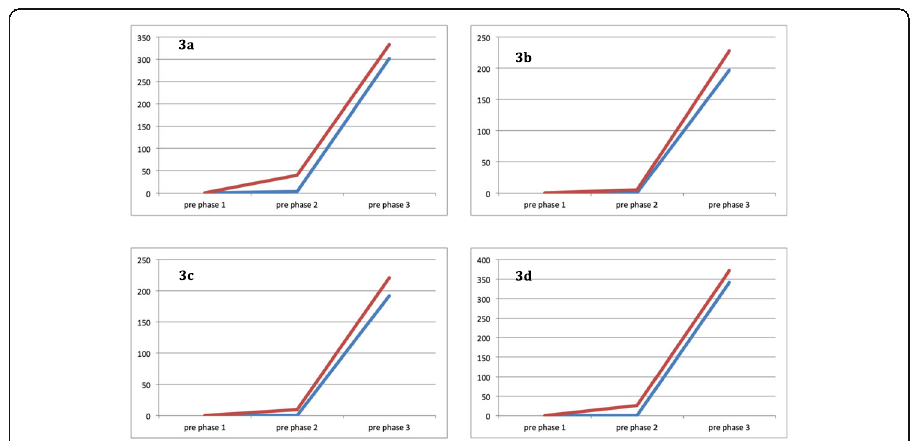
Fig. 3 rNPV calculations for the four interventions using indication specific FEC high and low costs and phase specific cumulative progressive success rate. P rogressive success rates indicated in Table 5 were used in the rNPV calculations for indication specific low (red line) and indication specific high (blue line)